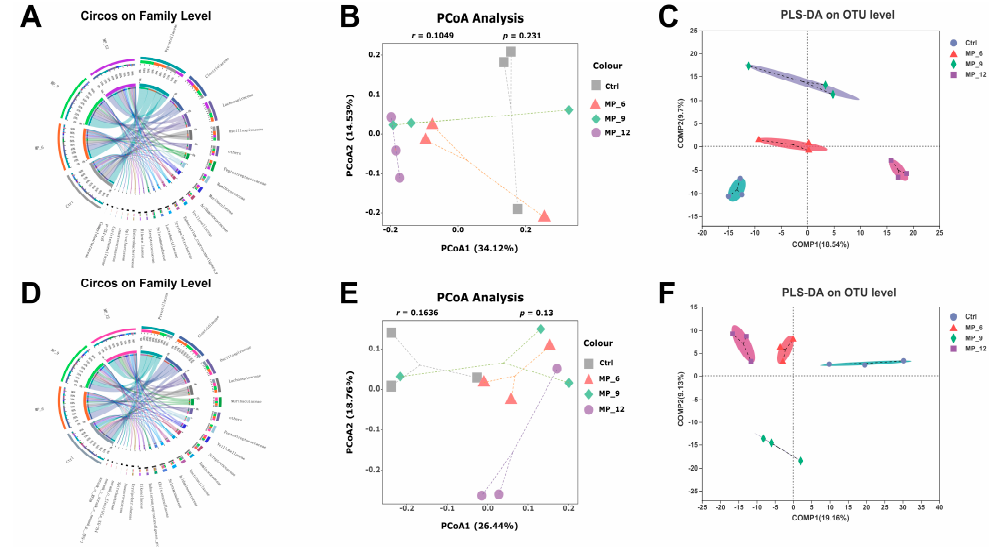
Figure 6. Hindgut microbial β -diversity in finishing pigs dietary supplementation of mulberry leaf powder of varying levels. ( A ) Circos diagram at family level in cecum. ( B ) PCoA at OTU level in cecum. ( C ) PLS-DA at OTU level in cecum. ( D ) Circos diagram at family level in colon. ( E ) PCoA at OTU level in colon. ( F ) PLS-DA at OTU level in colon. In the Circos sample–species relationship diagram, the small half-circle (left half-circle) illustrated the species composition in a sample, where the outer color represented the different groups, the inner color indicated the species and the length denoted the relative abundance of that species in the corresponding sample; the large half-circle (right half-circle) illustrated the proportional distribution of species in different samples at that family level, where the outer color represented the species, the inner color indicated the different groups, and the length denoted the proportional distribution of that sample in a particular species. PCoA, principal co-ordinate analysis, which was evaluated based on the bray_curtis algorithm and ANOSIM difference examination; PLS-DA, partial least squares discriminant analysis. Ctrl, basal diet with 0% MP; MP_6, MP_9 and MP_12 are the basal diets supplemented with 6%, 9% and 12% MP, respectively. n = 3.